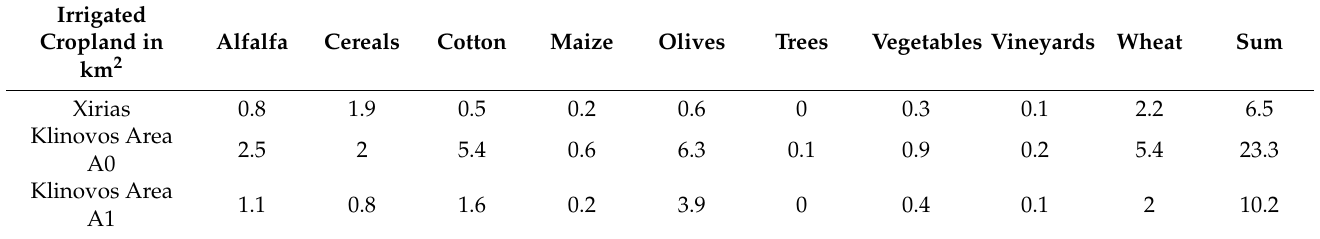
Table 4. Statistics of area extent of irrigated croplands from the storage water works of Xirias and Klinovos for the two cases simulated for the period